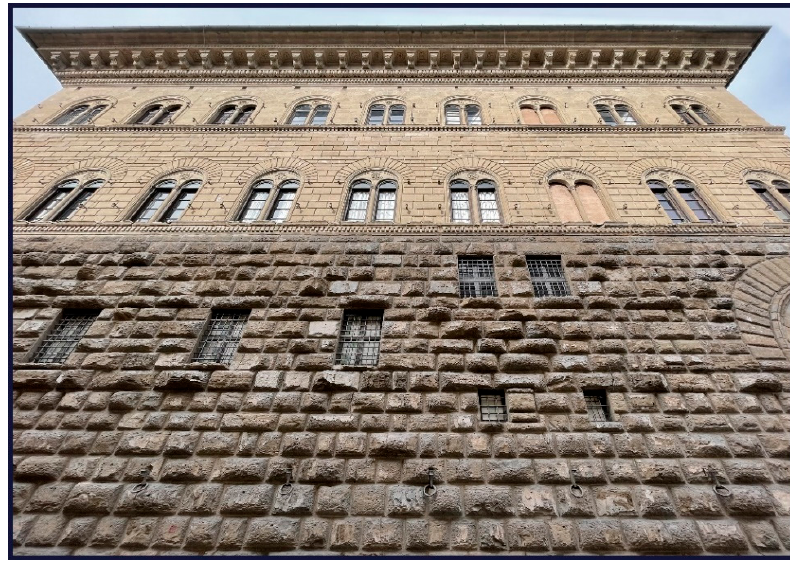
Figure 4. Facade of Palazzo Medici-Riccardi on Via Gori.